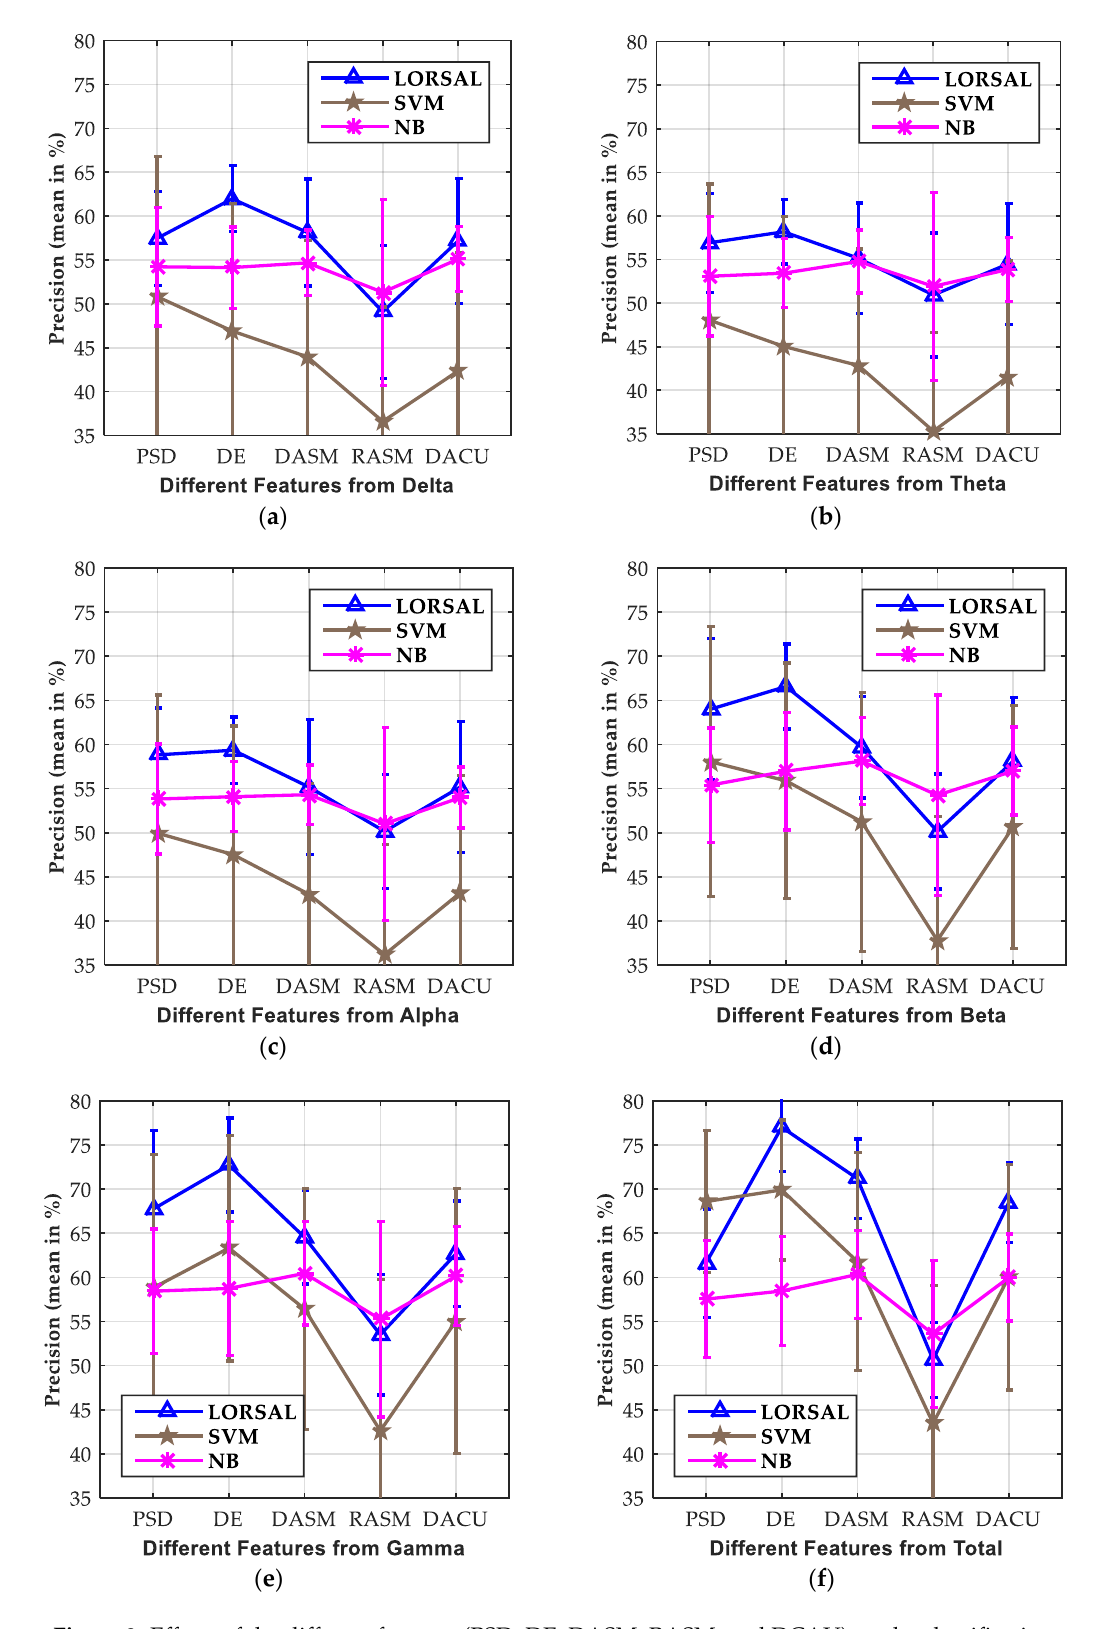
Figure 8. Effects of the different features (PSD, DE, DASM, RASM, and DCAU) on the classification precisions for LA/HA emotions obtained by the LORSAL, SVM, and NB classifiers from the six different frequency bands: ( a ) Delta, ( b ) Theta, ( c ) Alpha, ( d ) Beta, ( e ) Gamma, ( f ) Total.